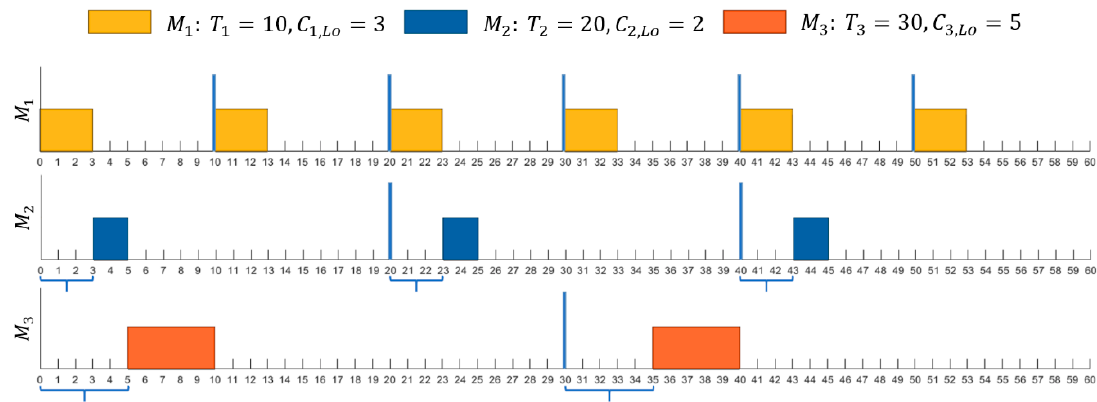
Figure 1. Start times for the three-task set example in Lo-criticality mode.